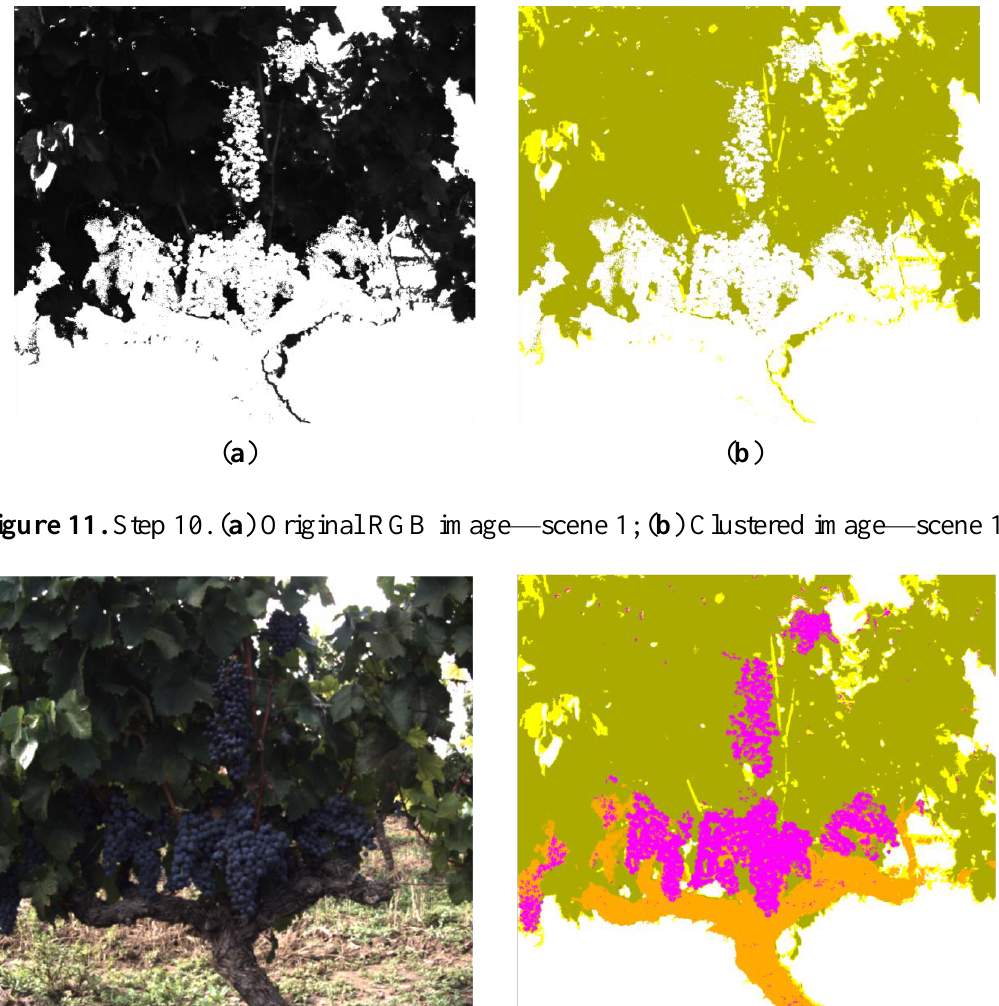
Figure 10. Step 9. ( a ) 660 nm image with background, fruits and stems masked; ( b ) Result of the K-means clustering.